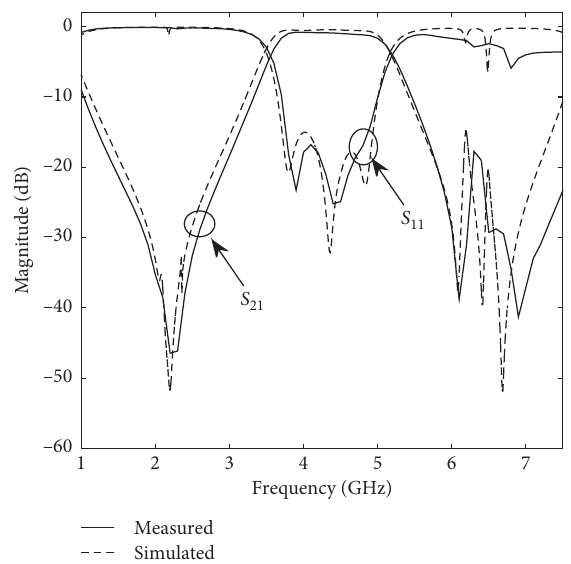
Figure 6: Simulated and measured S-parameters of the proposed